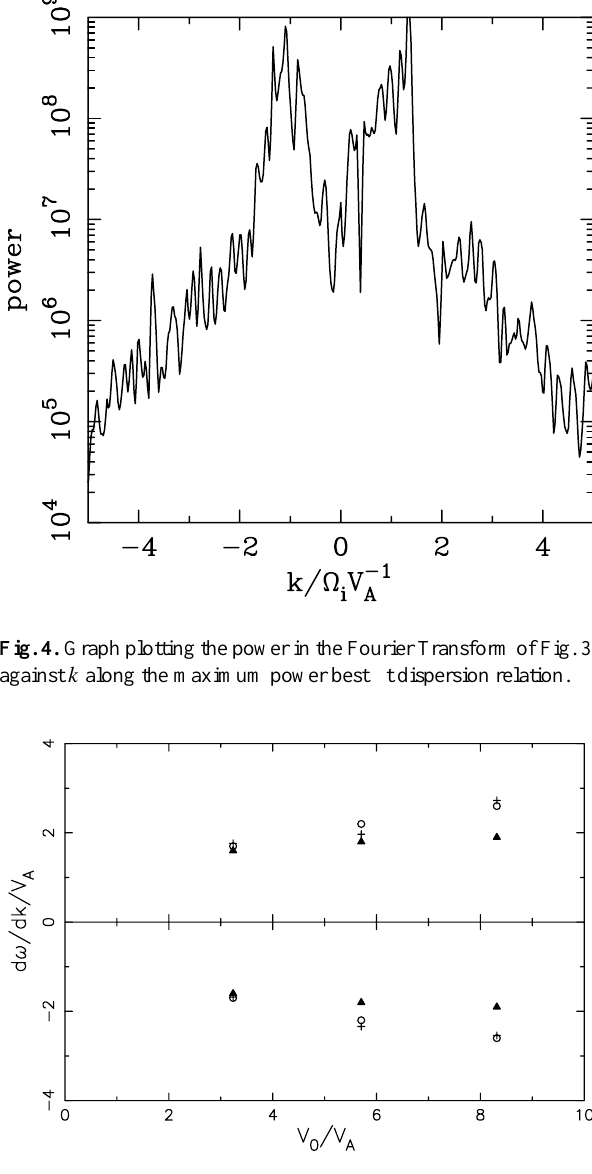
Fig. 5. Chart correlating the speed of ripples at the overshoot to = 85 ◦ . The crosses correspond other significant wave speeds at θ B n to the measured best χ 2 fit to the ripple speed, the open circles to the overshoot Alfv´en speed and the solid triangles to the downstream Alfv´en speed.